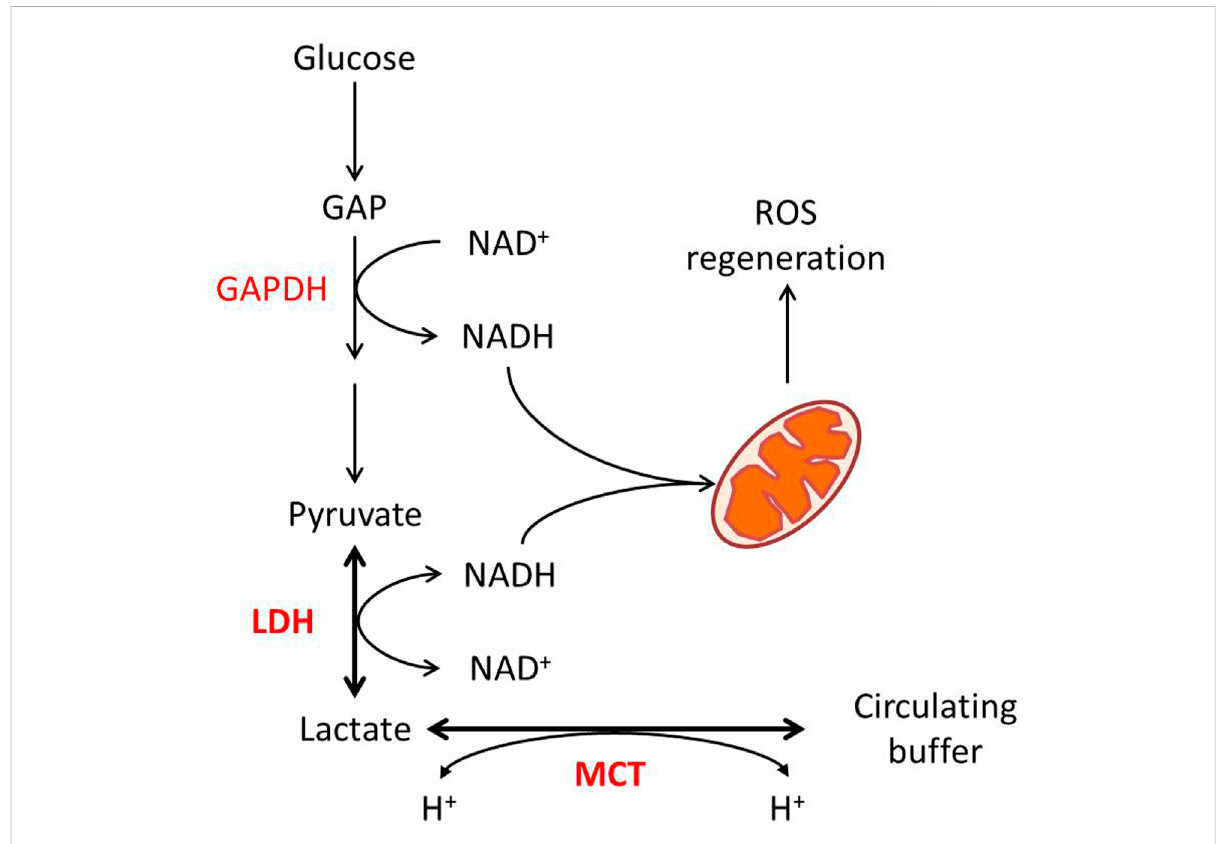
FIGURE 1 Lactate metabolism and redox homeostasis. Glycolytic fl ux from glucose to pyruvate generates NADH from NAD at the GAPDH reaction, while LDHA-catalyzed pyruvate to lactate consumes NADH. The pyruvate – lactate ratio in some conditions re fl ects the NAD – NADH ratio. MCT-mediated proton-dependent lactate transport maintains the balance between intracellular and circulated